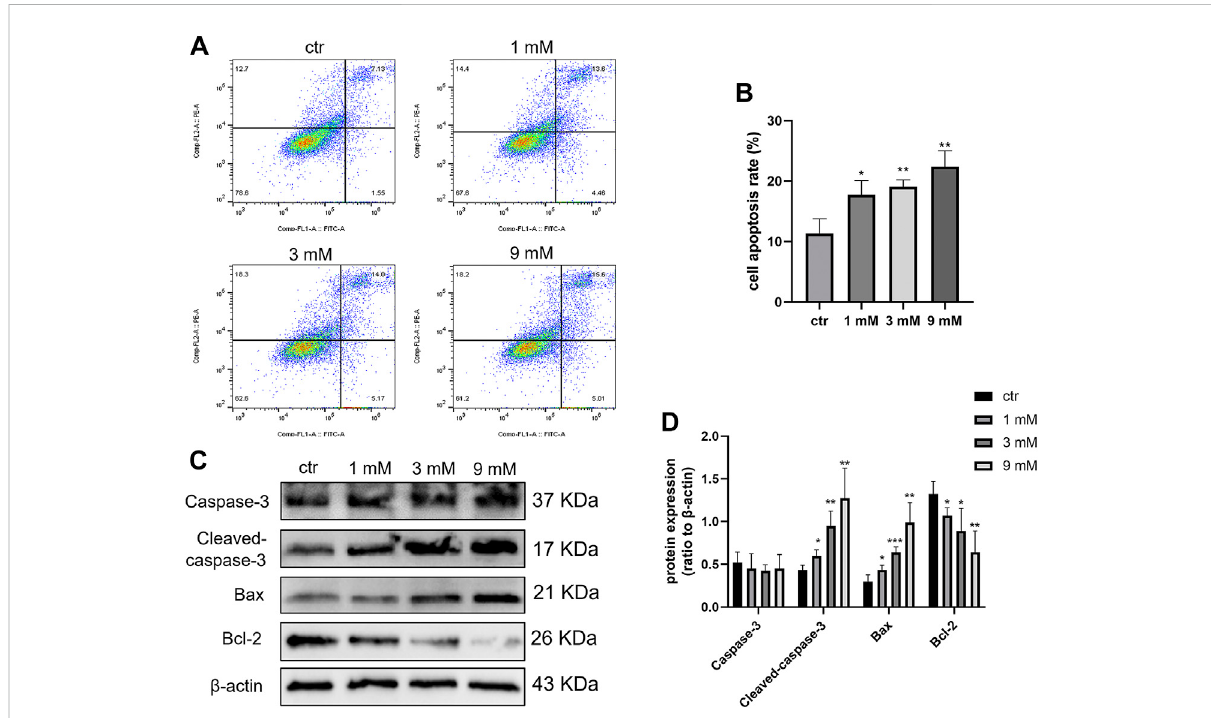
FIGURE 3 Cellapoptosis wasinducedbymetformin treatmentonDaoy cells. (A,B) Flowcytometrywasusedtoanalyze apoptosisonDaoycellsafter 24 h of metformin treatment ( n = 3), Annexin V-FITC-positive cells (Q2 + Q4) were considered as apoptotic. (C,D) Apoptosis-associated proteins were analyzed using western blot analysis. The relative Bcl-2, Bax, Caspase-3, and Cleaved-caspase-3 were normalized to that of β -actin ( n = 4). Data are presented as the mean ± SD, t-tests were used to determine the signi fi cance. * p < 0.05; ** p < 0.01; *** p < 0.001 compared with the control